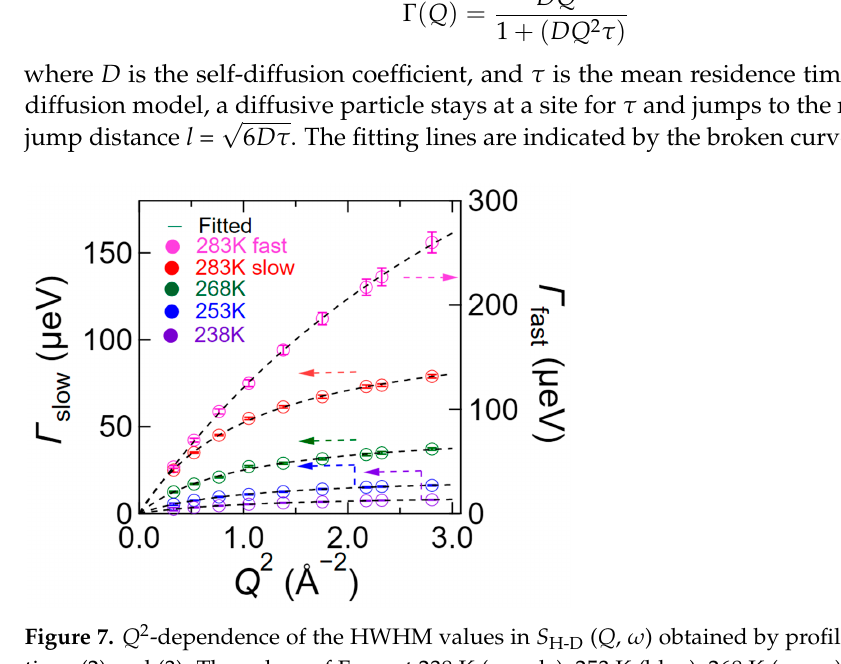
proton conduction in hydrated chitosan (i.e., 0.38 eV).